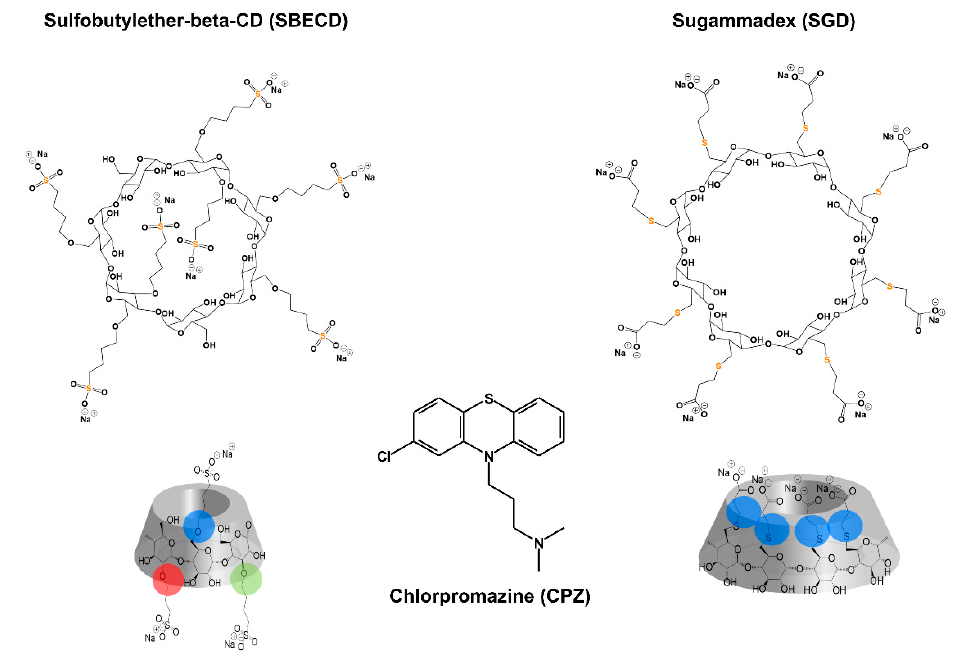
Figure 1. Chemical structures of sulfobutylether- β -cyclodextrin (SBECD), chlorpromazine (CPZ), and sugammadex (SGD), highlighting the location of substituents on the CD scaffolds (red, green and blue circles mark positions 2, 3 and 6, respectively).